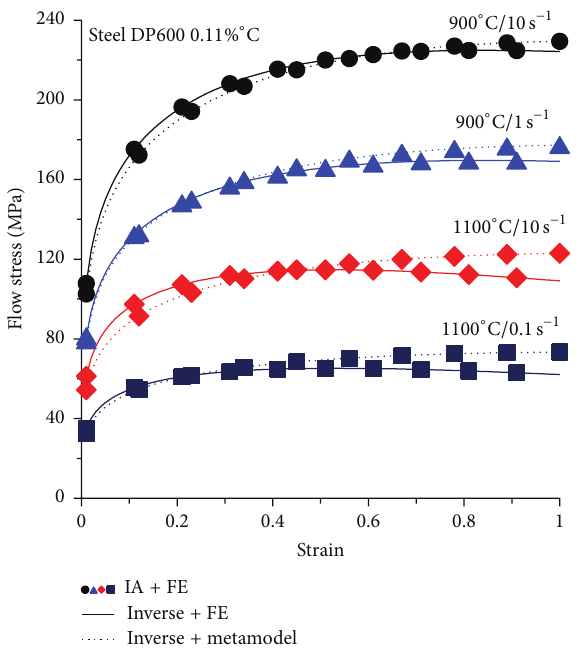
Figure 13: Flow stress calculated from (4) with coefficients obtained fromtheconventional IA+FEapproach (filled symbols)and inverse analysis with ANN (broken lines) and with clusterized metamodel (solid lines) for the steel